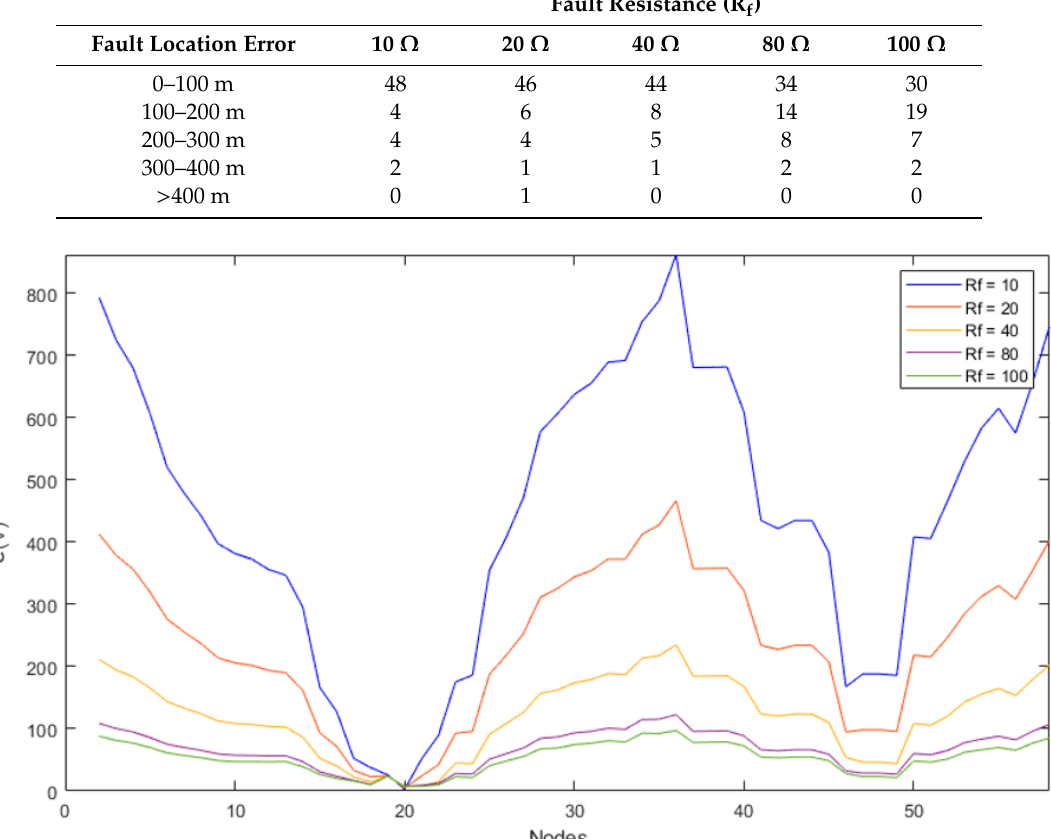
ff erent faults